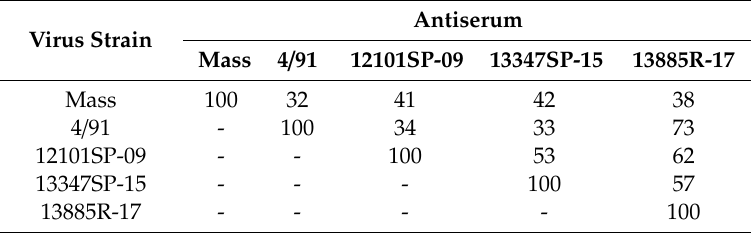
Table 2. Archetti and Horsfall antigenic relatedness (R) calculated on embryonated